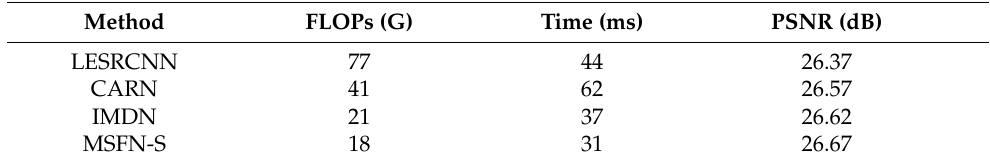
Table 4. Complexity of five networks for